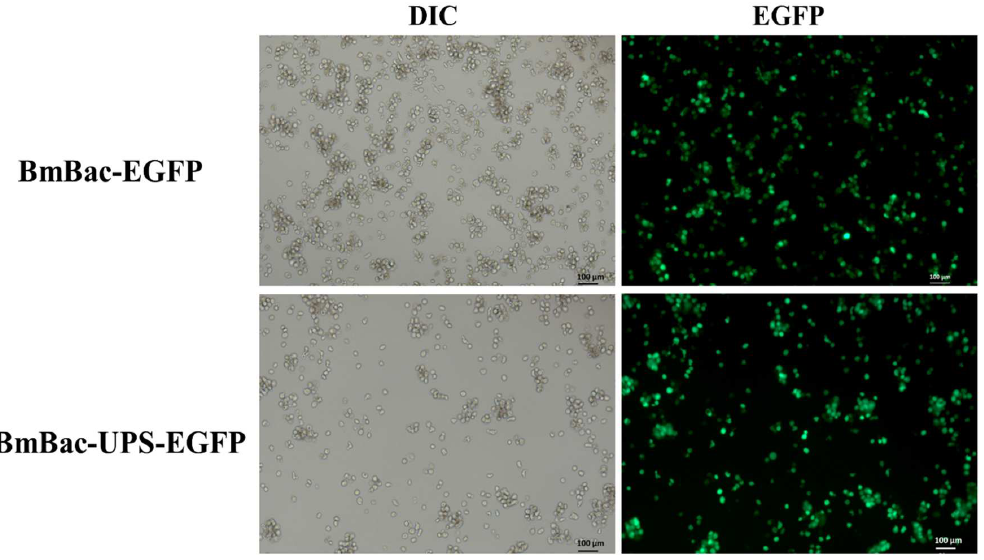
Figure 3. Detection of reporter gene expression in the BmN cells infected with BmBac-UPS-EGFP and BmBac-EGFP. Virus-infected cells were visualized by microscopy at 72 h after infection under differential interference contrast (DIC) and fluorescence (EGFP). The scale bars are 100 μm.